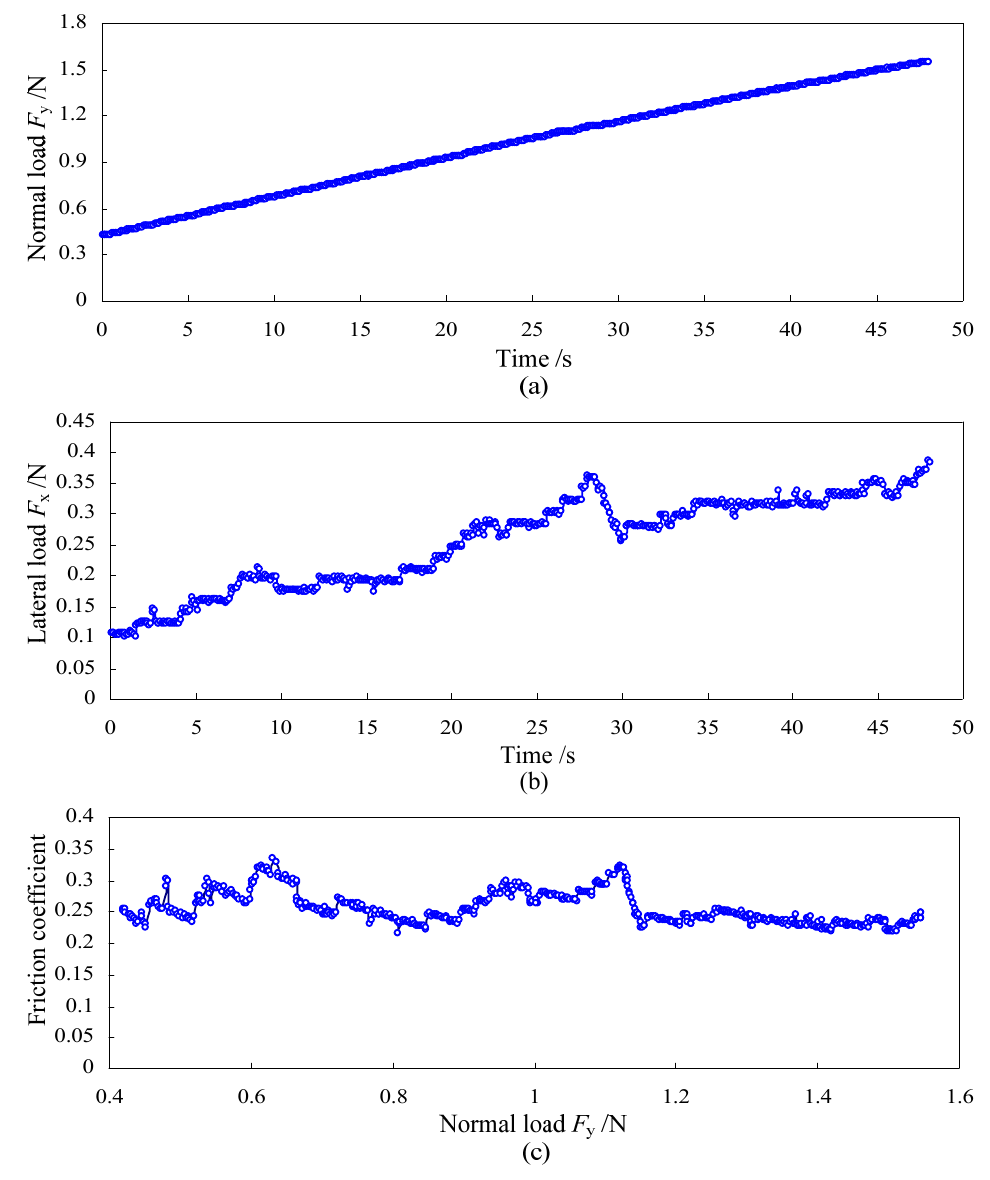
Figure 11. Scratch testing results of the Zr-based bulk metallic glass. ( a ) is the relationship between the normal load and time; ( b ) is the relationship between the lateral load and time; ( c ) is the relationship between the friction coefficient and the normal